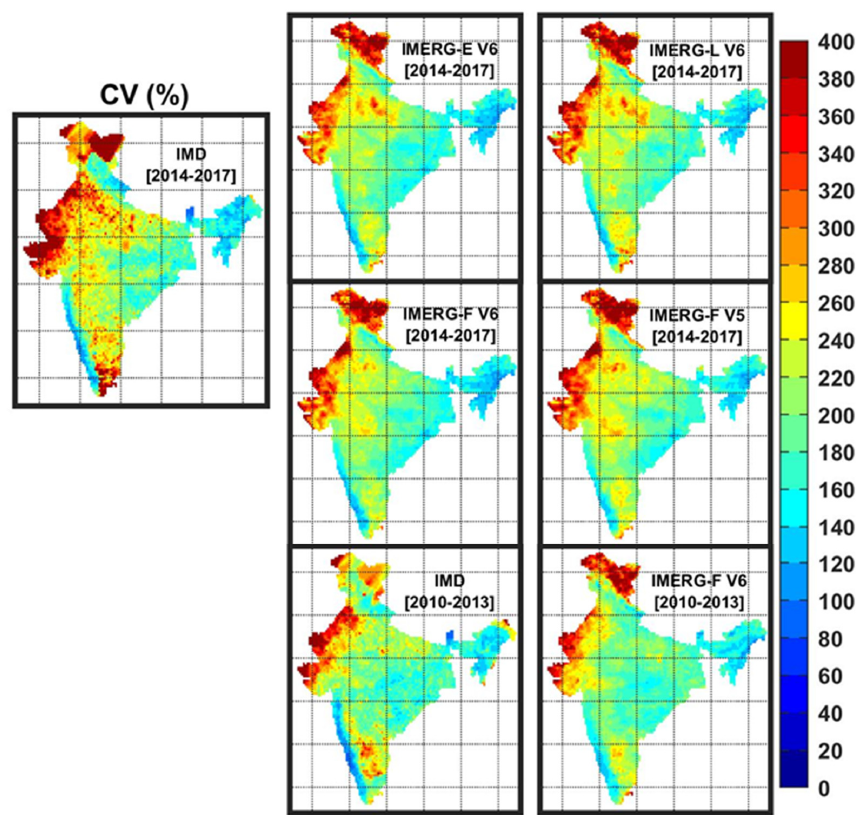
Figure 5. Spatial distributions of coefficient of variations (%) in daily monsoon rainfall across India from the IMD rain-gauge-based data and IMERG estimates for the GPM (2014–2017) and pre-GPM (2010–2013) periods.